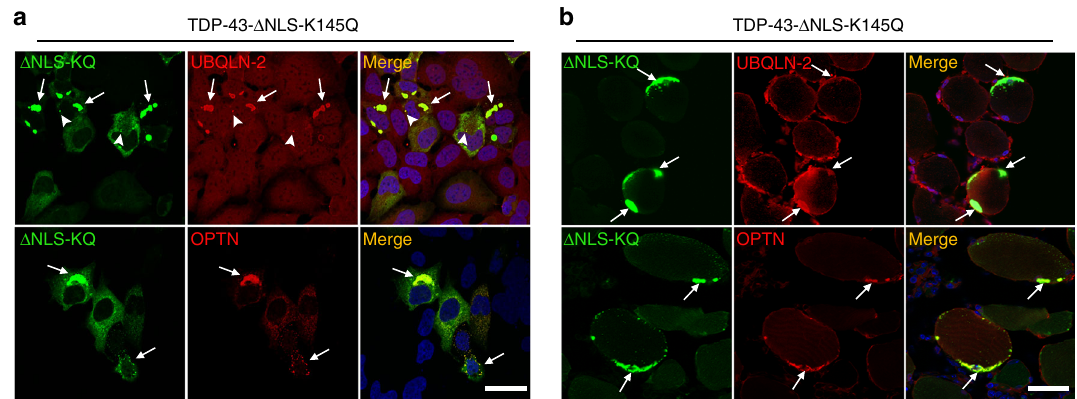
Fig. 4 Functionally linked co-pathologies emerge in response to TDP-43 acetylation-mimic aggregates. QBI-293 cells ( a ) or TA muscles ( b ) were transfected with GFP-tagged cytoplasmic localized TDP-43- Δ NLS-K145Q either alone (endogenous UBQLN-2 analysis) or in tandem with an OPTN expression plasmid for increased detection sensitivity. Either endogenous UBQLN-2 or ectopically expressed OPTN were detected by double-labeling immuno fl uorescence using GFP ( green ), UBQLN-2 ( red ), or OPTN ( red ) antibodies, while DAPI marked nuclei ( blue ). We note signi fi cant recruitment of both UBQLN-2 and OPTN to TDP-43 aggregates in either cell-based or muscle fi ber models. White arrows highlight recruitment of UBQLN-2 or OPTN to TDP-43 aggregates. Arrowheads indicate occasional co-localization of UBQLN-2 to smaller TDP-43 pre-aggregates. Scale bar = 50 μ